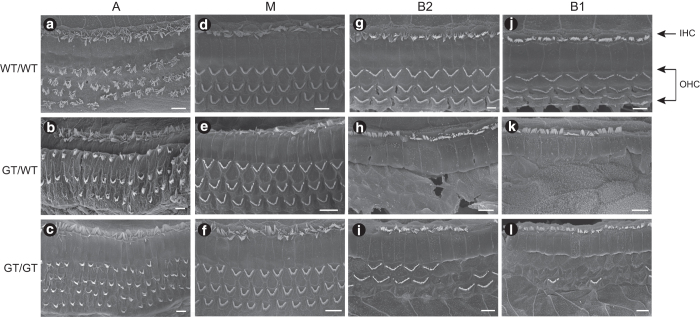
Degeneration of cochlear cells in 14-3-3eta mutant mice. Scanning electron microscopy of the organ of Corti at the apical turn (A; a–c), the middle turn (M; d–f) , the upper basal turn (B2; g–i) and the lower basal turn (B1; j–l) obtained from 6-month-old 14-3-3etaWT/WT (a, d, g and j), 14-3-3etaGT/WT (b, e, h and k) and 14-3-3etaGT/GT (c, f, i and l) mice. Both IHCs and OHCs are regularly aligned in the apical and middle turn of all genotype. In the basal turn (B1, B2) OHCs loss is observed in 14-3-3etaGT/WT and 14-3-3etaGT/GT. Scale bars: 5 μm.